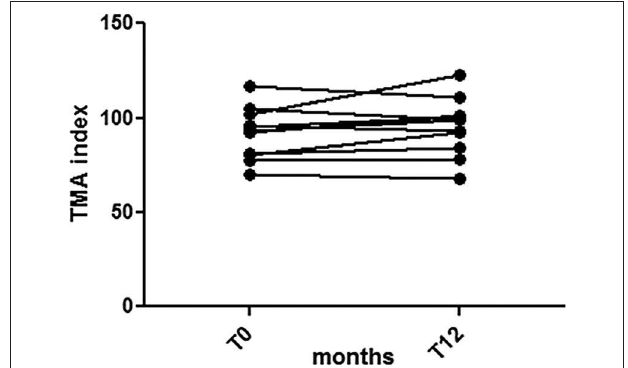
FIGURE 3 | Self-esteem assessment. Seven out eleven patients with HIV infection reached or exceeded a score of 85 at T0. After 12 months of intervention, 8/11 had a score higher than 85. Of the four patients with an initial score below 85, only one patient scored more than 85 at the 12-month follow-up; the other three did not show any improvement in self-esteem. Overall, the results showed that HIV-infected adolescents exhibited a good level of